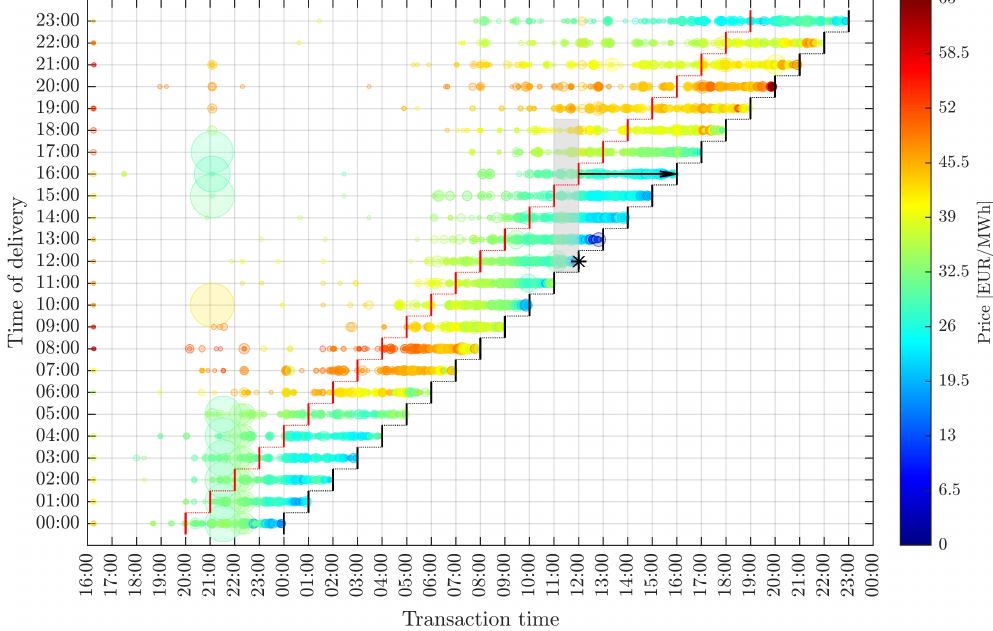
Figure 3. Illustration of the forecasting framework using actual transaction data from the German intraday, continuous-time market for hourly products from 26 April 2018 16:00 to 27 April 2018 24:00. The black step function represents the moment the delivery starts (every hour of Friday, 27 April 2018), the circles refer to actual trades, with circle size indicating the traded volume (from 0.1 to 300 MWh) and color the price (see the colorbar on the right), and the red step function represents the moment the forecasts are made. For instance, at 12:00 on 27 April 2018 when forecasting the price for 16:00 ( ), −→ the most recent ID3 value is for 12:00 ( ). The grey-shaded area indicates the data used for computing ∗ the seven partial ID3 indices utilized when forecasting the price for hour 16, see Section 3.2.3 for